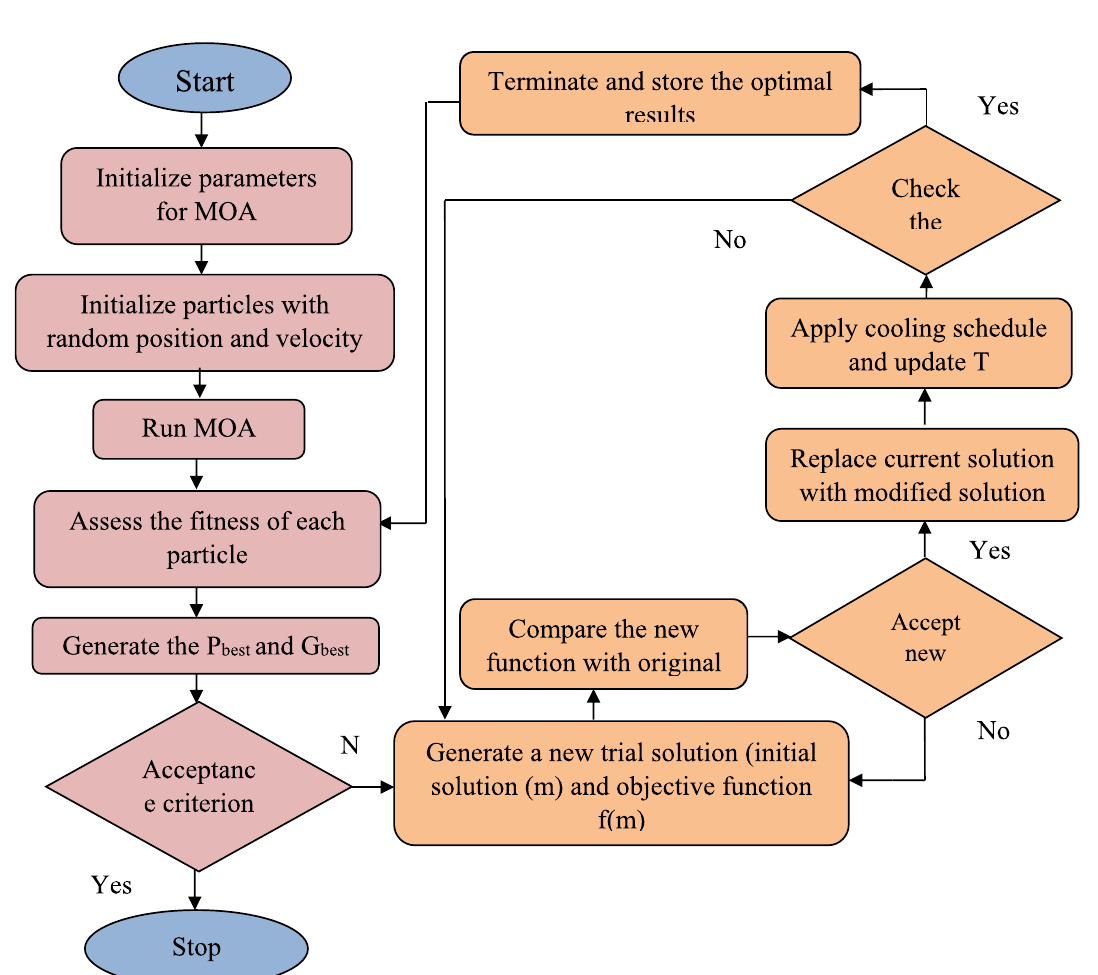
Fig. 4 Flowchart of the MOA–SA